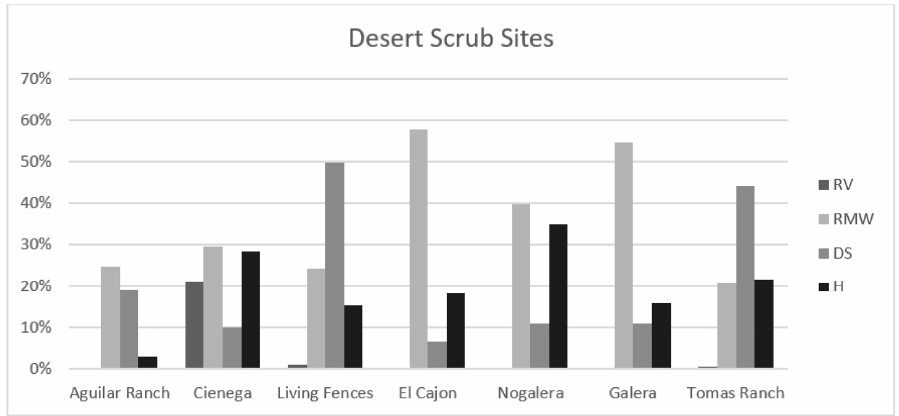
Figure 7. Cover percentage for Land Cover Classes for each site, derived from orthomosaics of Desert Scrub sites. RV (Riparian Vegetation), RMW (Riparian Mesquite Woodland), DS (Desert Scrub), H (Herbaceous cover).